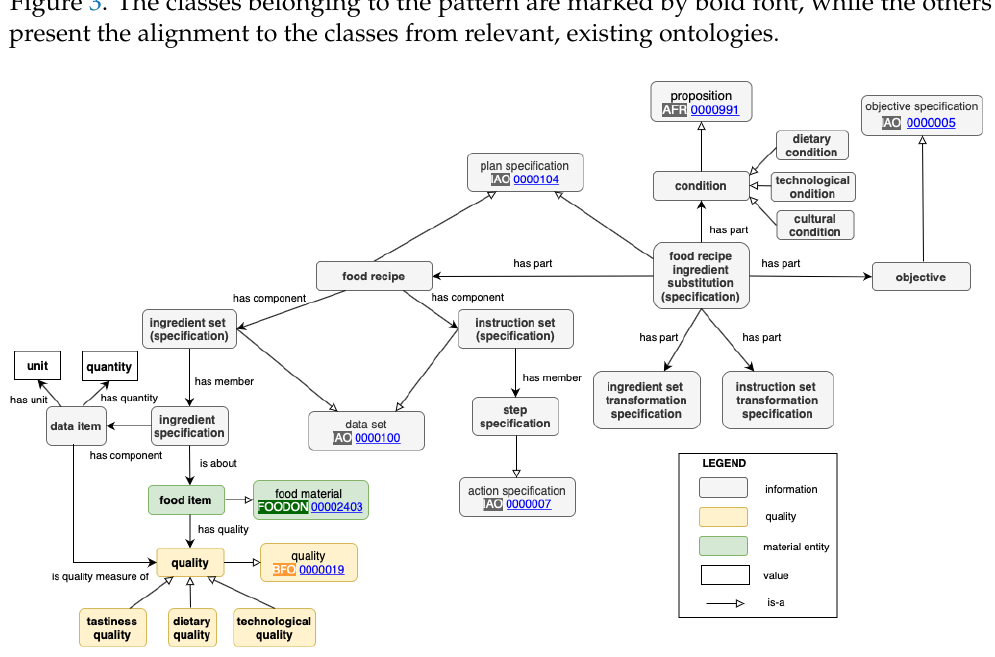
Figure 3. Graphical representation of the pattern and mapping to relevant terms from existing